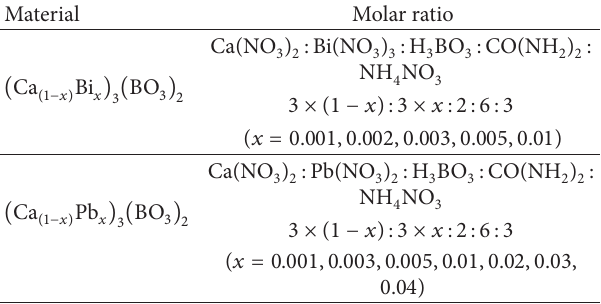
Table 1: Molar ratio of ingredients used for material preparation. Material Molar ratio